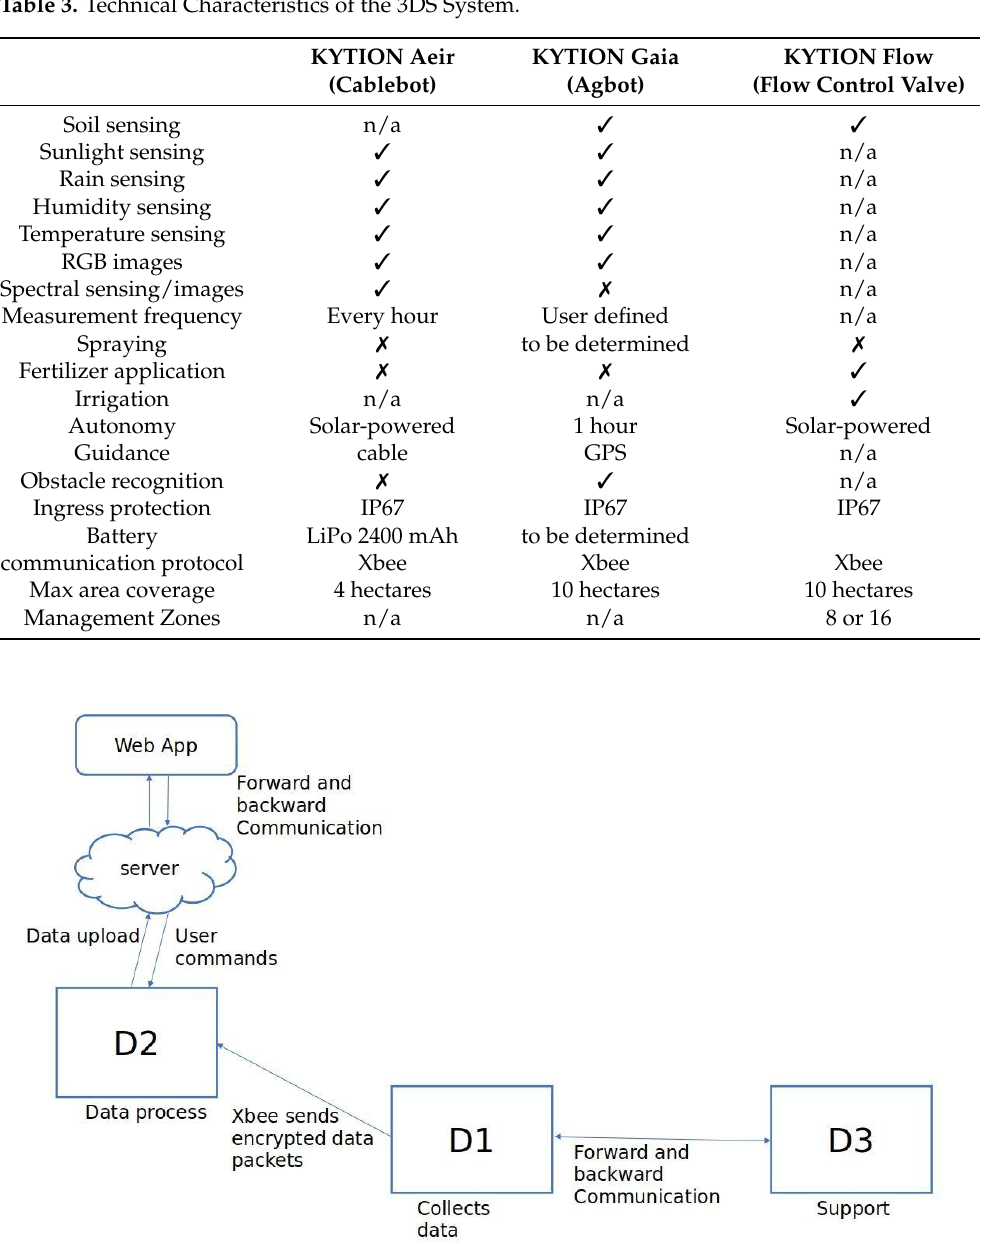
Figure 4. Operational Method of the 3DS System. D1 Operation: The operation of D1 is to be controlled by an Arduino Pro Mini which controls the time intervals between data collection and the overall device movement. The whole process will be controlled by an automatic relay to avoid unnecessary waste of energy. A 12-volt operation is to be achieved through a buck converter (Figure